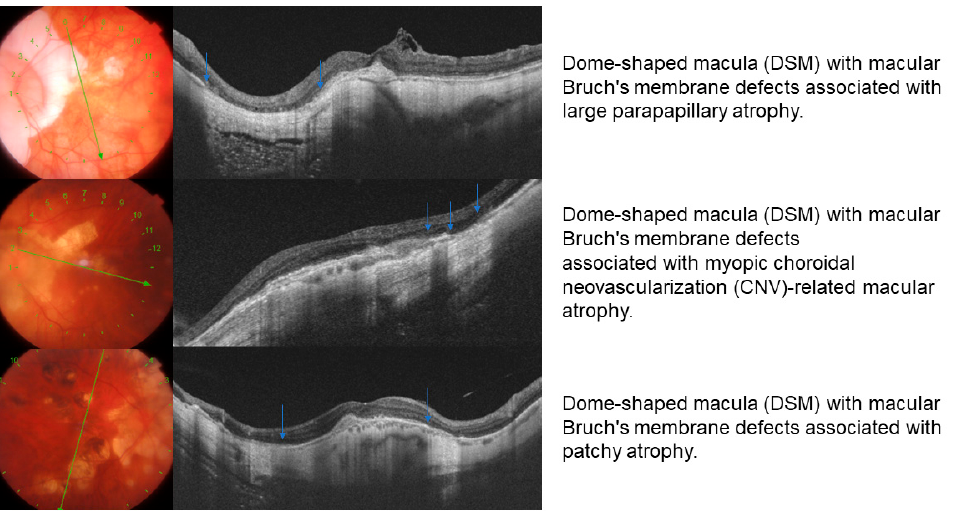
Figure 4. Bruch membrane defects: different patterns. Blue arrows mark the areas with Bruch ´ s membrane defects.